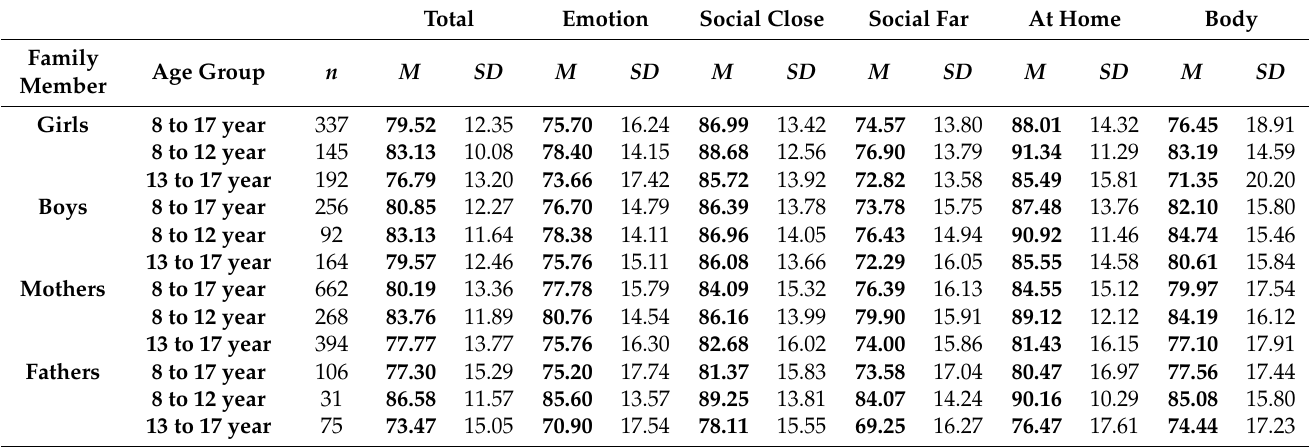
Table 5. Descriptives, DUX-25 Scale Means by Family Member and Age